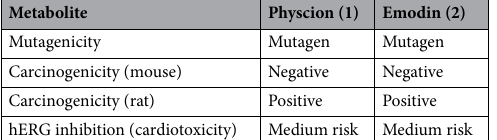
Table 4. Predicted toxicity profile of physcion ( 1 ) and emodin ( 2